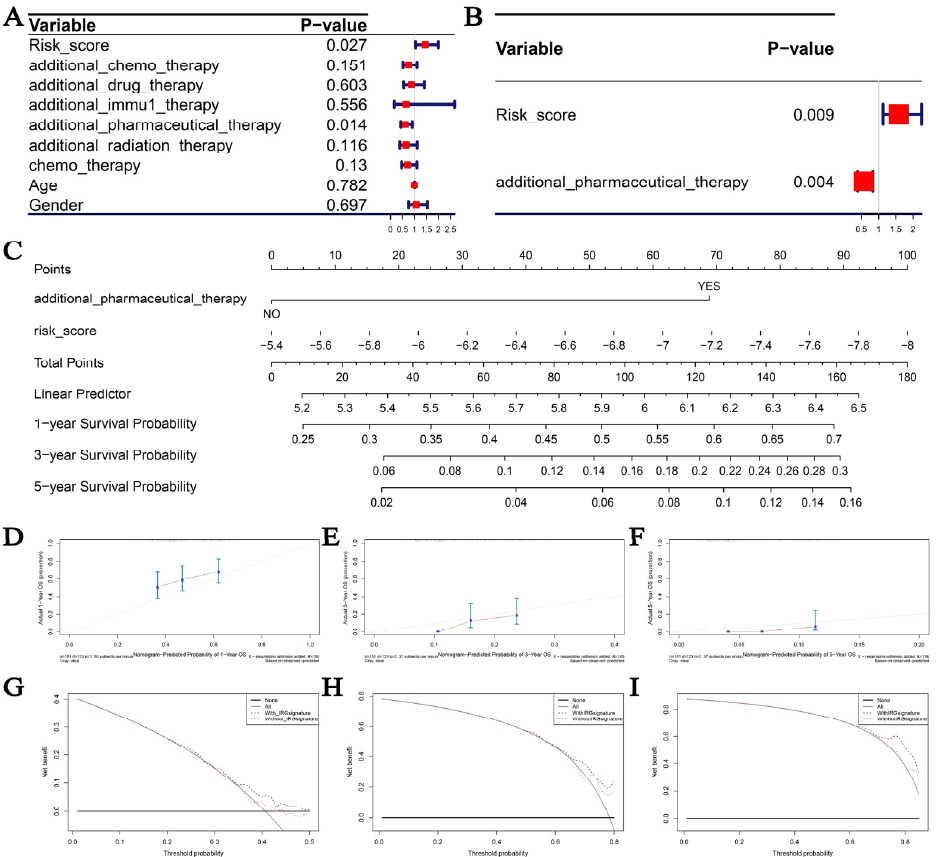
Figure 10. ( A ) Forest plot summary of OS univariate analysis of risk score, chemotherapy, drug therapy, immunotherapy, pharmaceutical therapy, radiation therapy, age, and gender based on TCGA-GBM data. ( B ) OS univariate analysis of risk score via forest plot summary, risk score, and